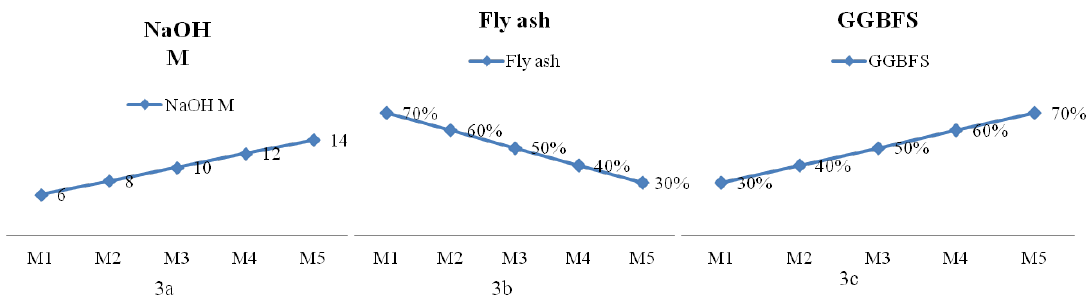
Figure 3. Dissimilar molarities of NaOH solution ( a ), fly ash percentage ( b ), and GGBFS percentages ( c ) for di ff erent geopolymer concrete mix.